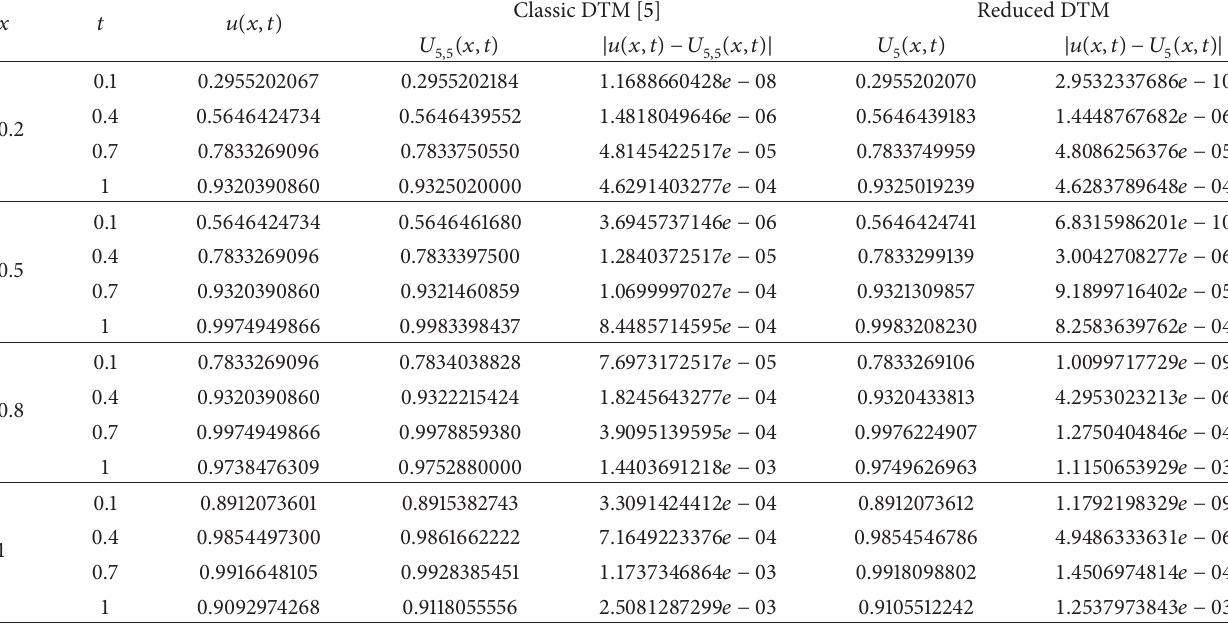
Table 4: Comparisons of the exact solution 𝑢(𝑥, 𝑡) = sin (𝑥 + 𝑡) , with 𝑈 5,5 (𝑥,𝑡) obtained by classic DTM [5] and 𝑈 5 (𝑥,𝑡) obtained by reduced DTM at some test points (𝑥,𝑡) in Example